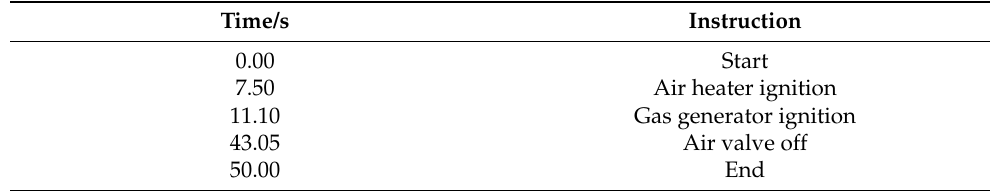
Table 1. Time sequence of the experiment.